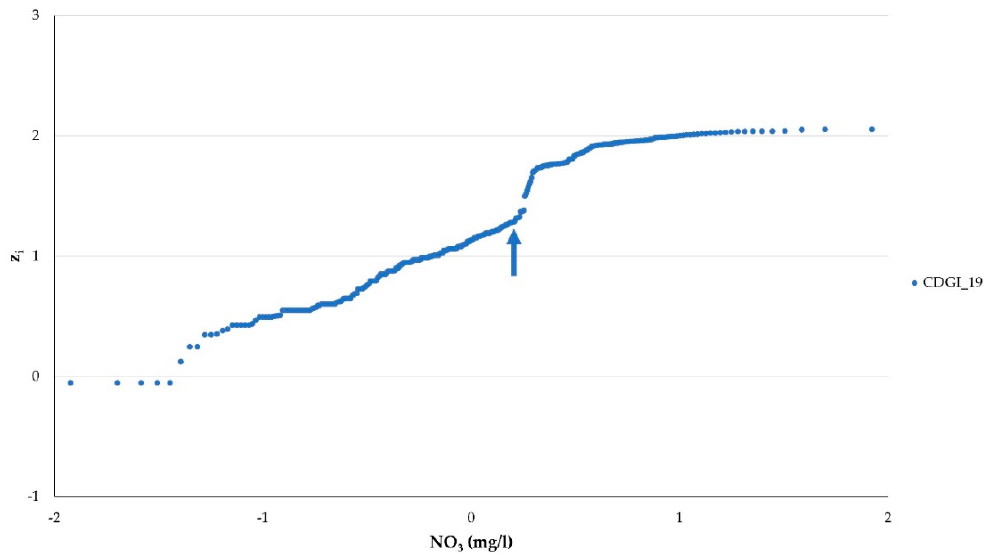
Figure 14. Lognormal probability plot of nitrate (NO 3 ) for the groundwater body CDGI_19. Arrow indicates inflection point that separates ambient and non-ambient populations.